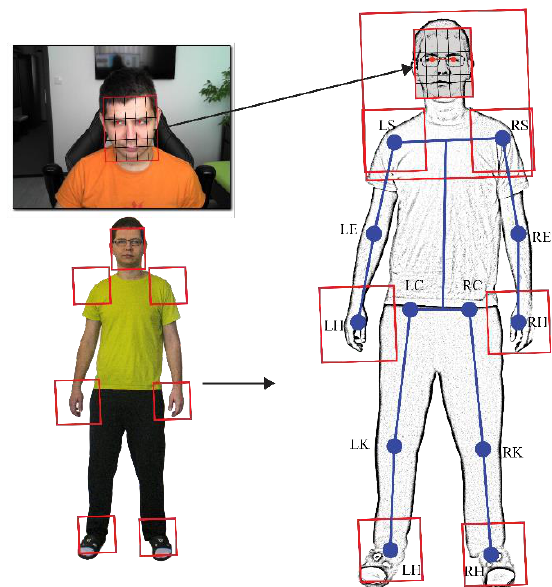
Figure 3. Skeleton model mapping (first L is for left, vice versa R for right, LH – hand, LE – elbow, LS – shoulder, LC – hip or coxa, LK – knee, LH – heel).